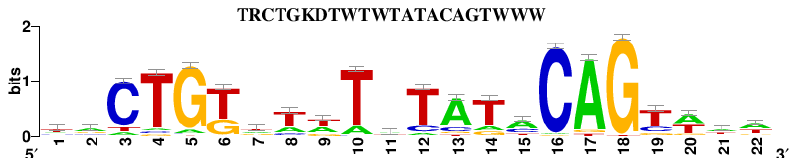
Figure 5. Position weight matrix (PWM) of LexA transcription factor binding (from RegulonDB— http://regulondb.ccg.unam.mx/ (accessed on 10 March 2022)).